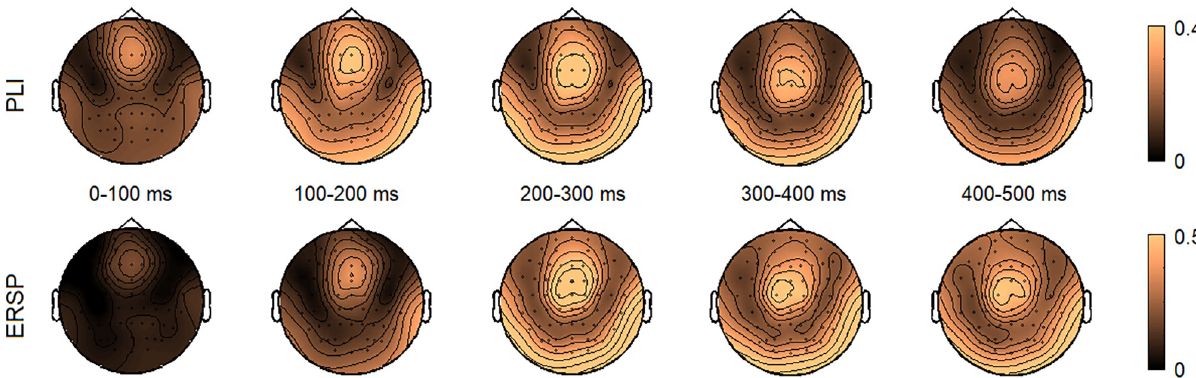
Fig 1. The topographies of PLI (upper panel) and ERSP (lower panel) within 0–500 ms time window in 100 ms bins in response to 40-Hz stimulation.